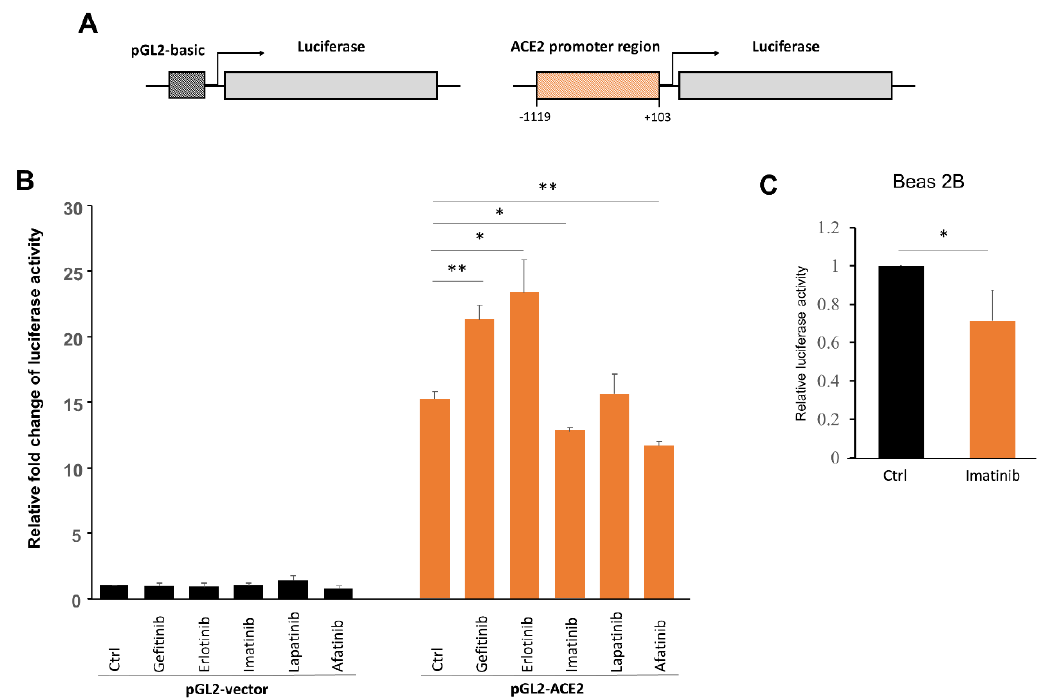
Figure 1. Imatinib inhibited the reporter activity driven by the ACE2 promoter. ( A ) Schematic illustration of the ACE2-luc reporter construct (ACE2( − 1119)-luc). ( B ) The reporter plasmid ACE2( − 1119)-luc or the backbone control vector (pGL2) was transfected into 293T cells, followed by treatments with the indicated drugs for 24 h with doses of gefitinib (2.5 µ M), erlotinib (2.5 µ M), lapatinib (2.5 µ M), or imatinib (2.5 µ M). The luciferase activity was then measured and plotted. Bars, standard deviation; * p < 0.05; ** p < 0.01; the p-values were determined by Student’s t -test. ( C ) Beas 2B cells were transfected with ACE2( − 1119)-luc, treated with and without imatinib (at 10 µ M for 24 h), followed by the analysis of luciferase activities as described in ( B ). Bars, standard deviation; * p < 0.05 determined by Student’s t -test.